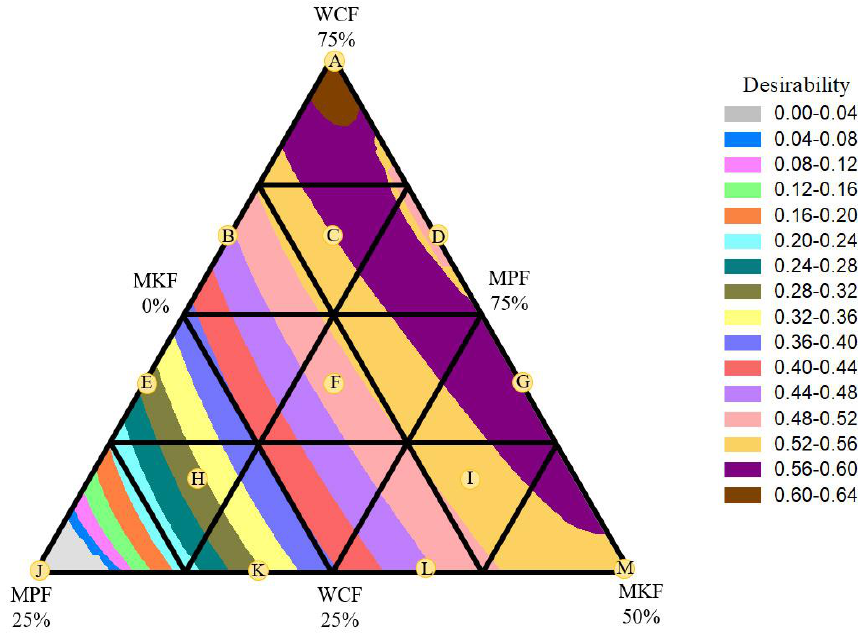
Figure 3. Simultaneous optimization of response variables for mixture design.